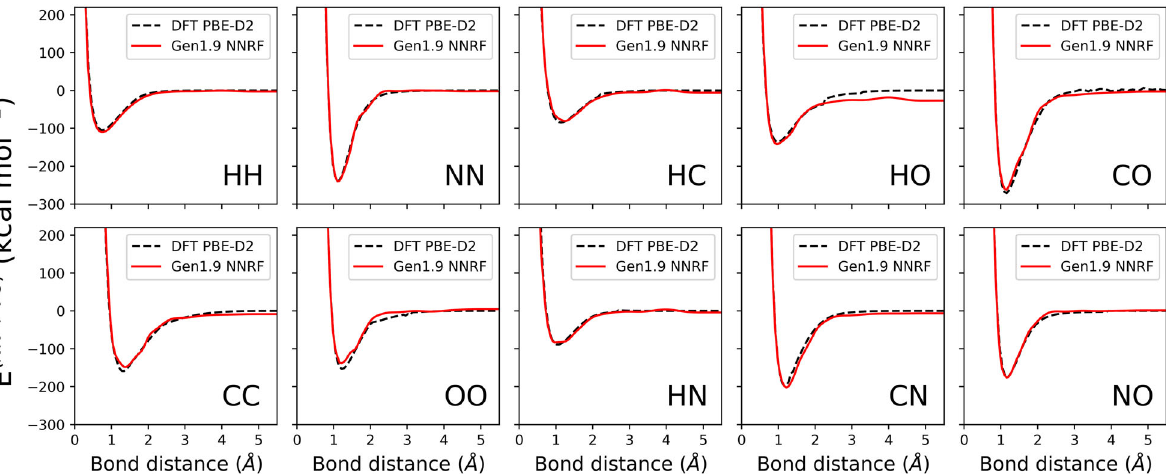
Fig. 5 The diatomic molecule dissociation curves. The dissociation curves for all possible combinations (H 2 , C 2 , N 2 , O 2 , HC, HN, HO, CN, CO, NO) using the spin-polarized DFT PBE-D2 and Gen1.9